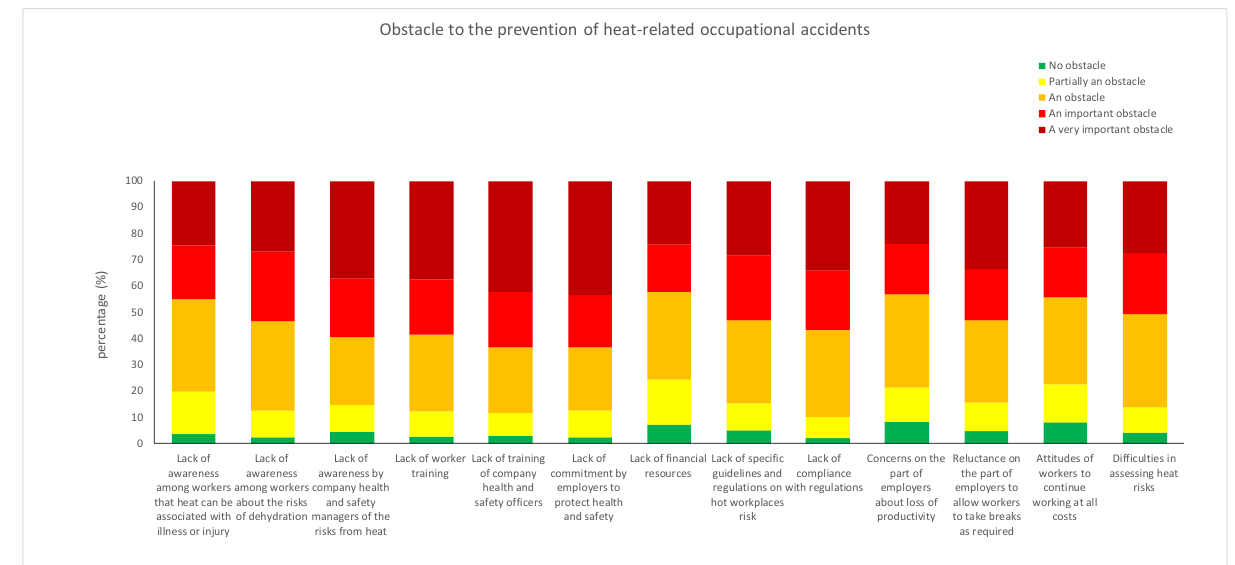
Fig 4. Percentages of answers to question 81 - To what extent do you think that each of the following conditions Figure 4. Percentages of answers to question 81—To what extent do you think that each of the following conditions can hinder prevention of heat-related occupational injuries? (A 5-point Likert can hinder prevention of heat-related occupational injuries? (A 5-point Likert scale from 1=no obstacle at all scale from 1 = no obstacle at all to 5 = a very important to 5=a very important obstacle).